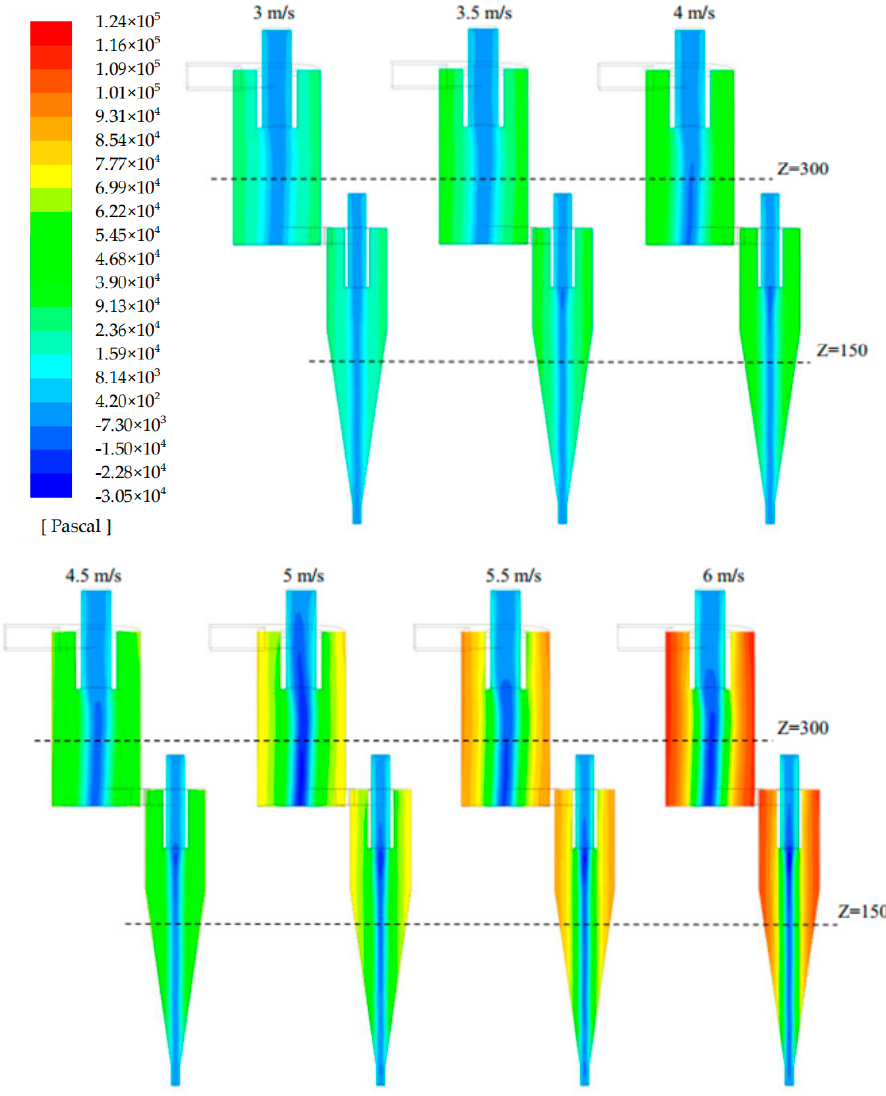
Figure 5. Pressure distribution contours.